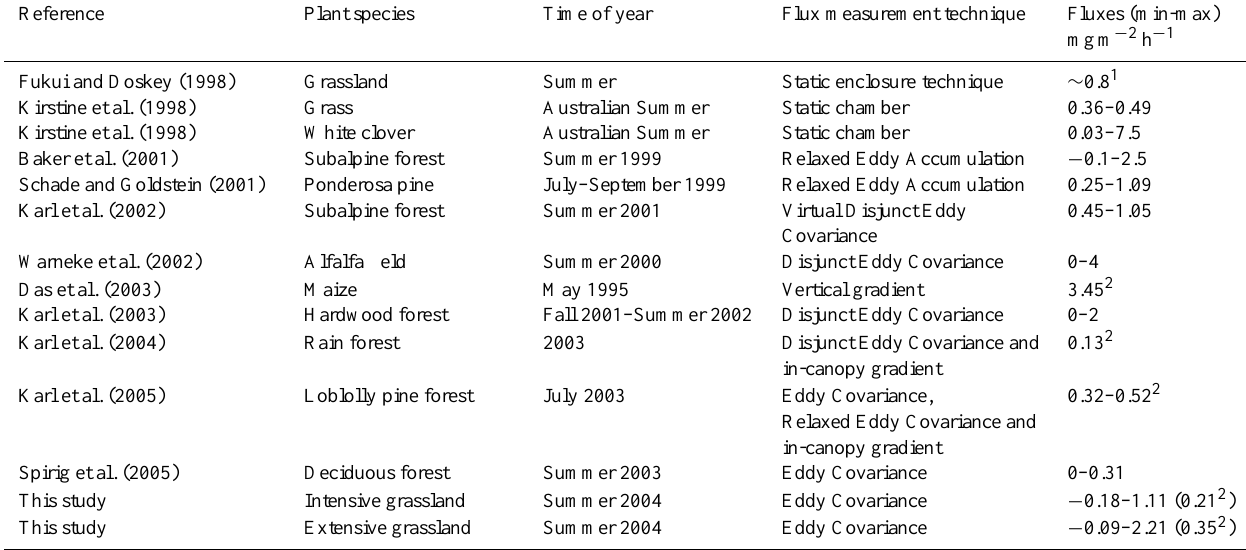
Table 3. Methanol fluxes measured in field